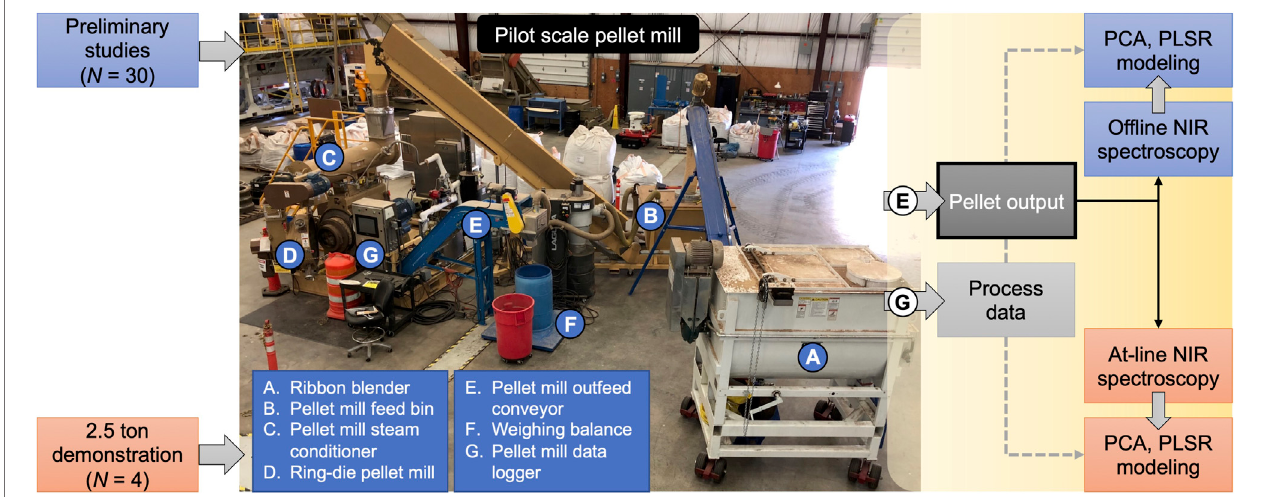
FIGURE 1 | Illustration of high-moisture pelleting of southern yellow pine (SYP) and switchgrass (SG) blends at the pilot-scale set-up (Legend: N – number of treatments; NIR – near infrared spectroscopy; PCA – principal component analysis, PLSR – partial least squares regression).